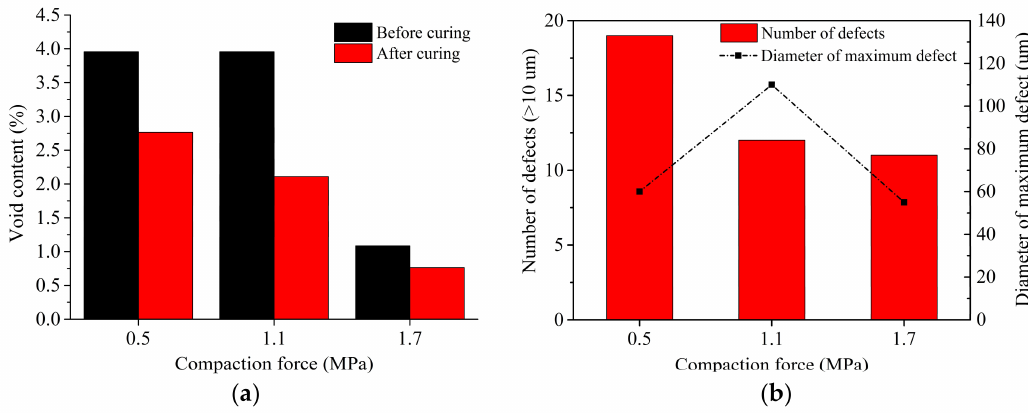
Figure 13. The relationship between defect distribution and compaction force at S of 20 mm · s − 1 and T of 40 ◦ C during the laying process: ( a ) void content; and ( b ) number of defects and diameter of maximum defect.